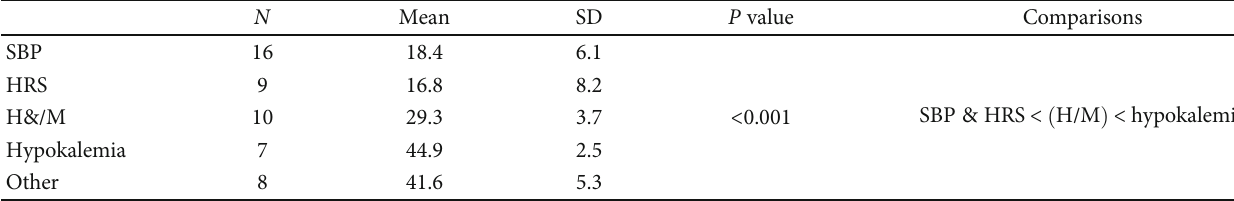
Table 5: Comparison of 25-OHD level in di ff erent HE etiologies.